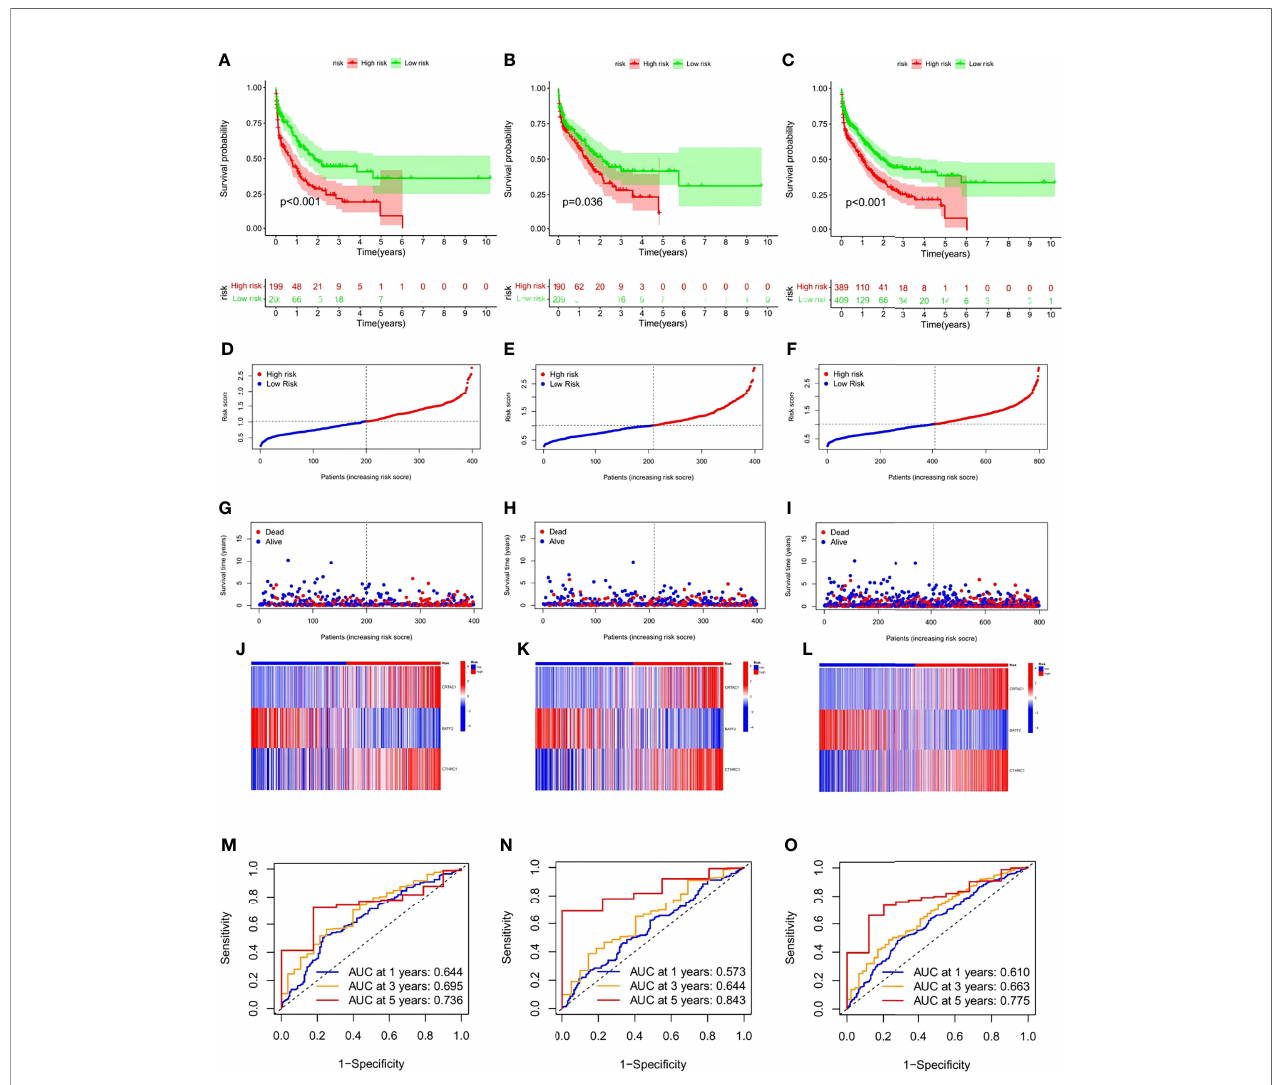
FIGURE 7 | Validation of the risk signature in training, testing sets,and the two combined. (A – C) Kaplan-Meier survival analysis between the high- and low-risk score groups in training, testing sets, and the two combined. (D – F) Scatter plots showing the survival status of STAD patients with increasing risk scores. (G – I) Ranked dot plots indicating the risk score distribution. (J – L) . Heat maps showing the distribution of the three candidate genes. (M – O) ROC curves predicting the sensitivity and speci fi city of 1-, 3- and 5-year survival according to the risk